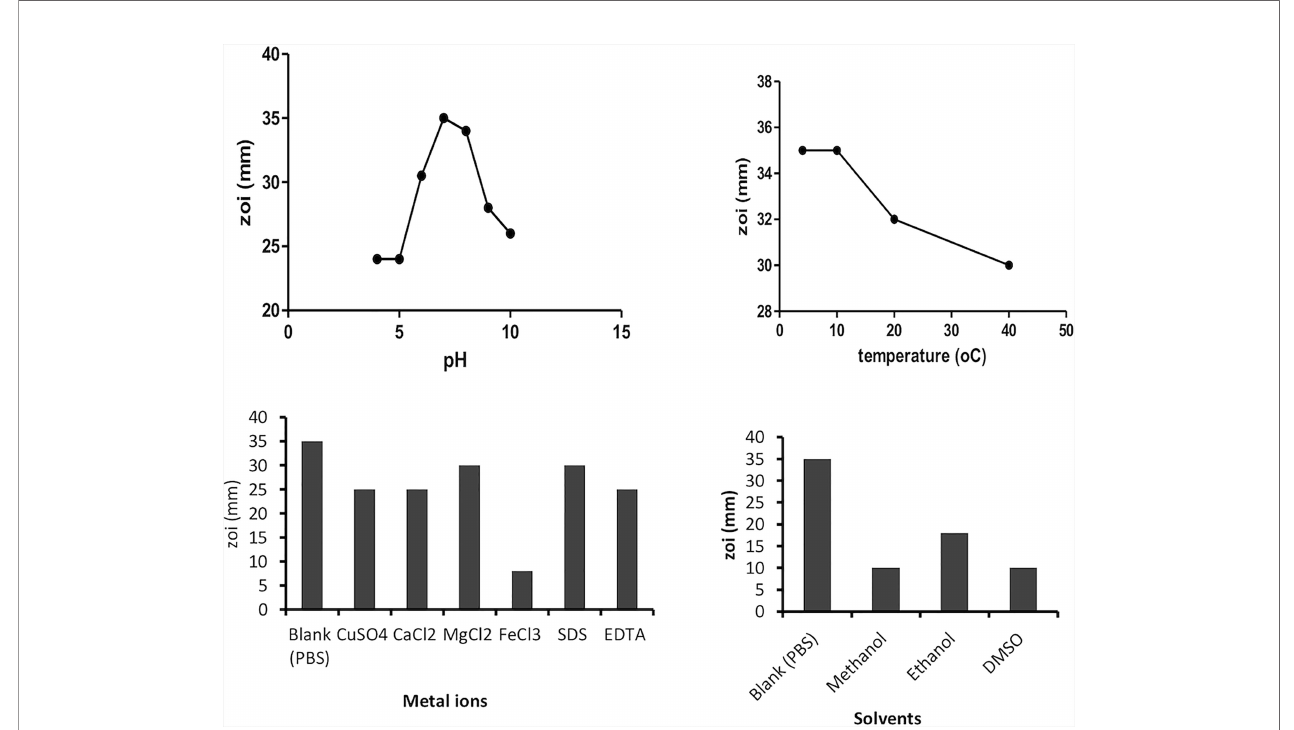
FIGURE 2 | Effect of various factors (temperature, pH, solvents, and metal ions) on plant protein activity.